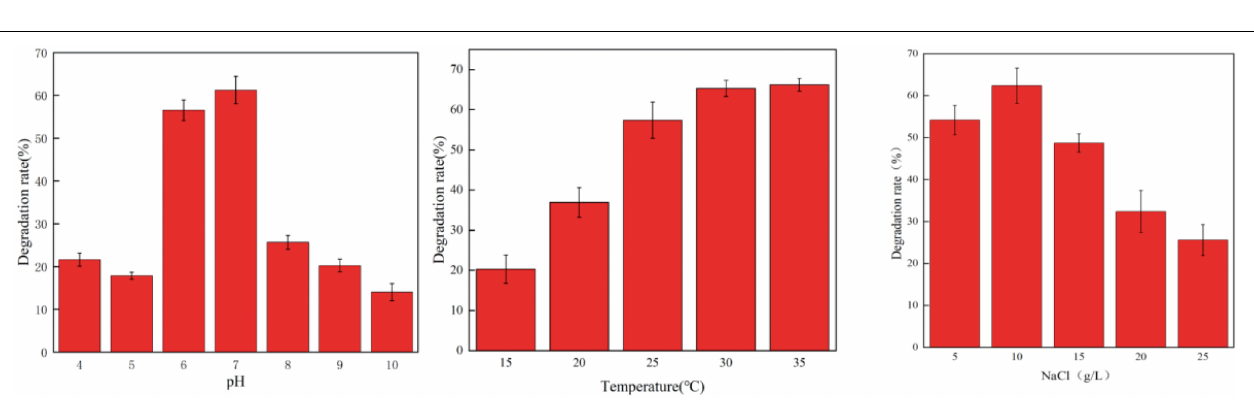
FIGURE 3 | The Effect of different pH values (left, 30 ◦ C, 10 g/L NaCl), temperatures (middle, PH = 7, 10 g/L NaCl), and NaCl concentrations (right, 30 ◦ C, PH = 7) on the degradation rate of OFL by strain HD1.